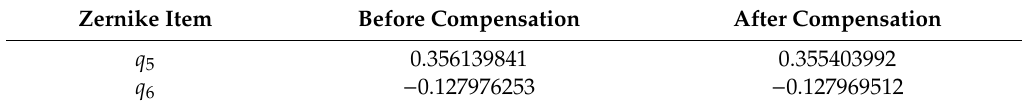
Table 5. Zernike coe ffi cients for wavefront aberration before and after Z-coordinate distortion compensation. Zernike